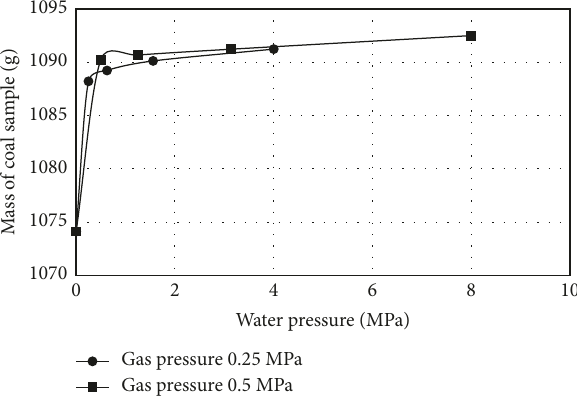
Figure 8: Mass of the coal sample as a function of water pressure after desorption for coal sample #2 (the initial mass of the coal sample is 1074.1g before